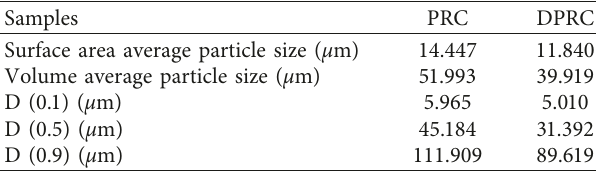
Table 1: Particle size analysis of PRC and DPRC.